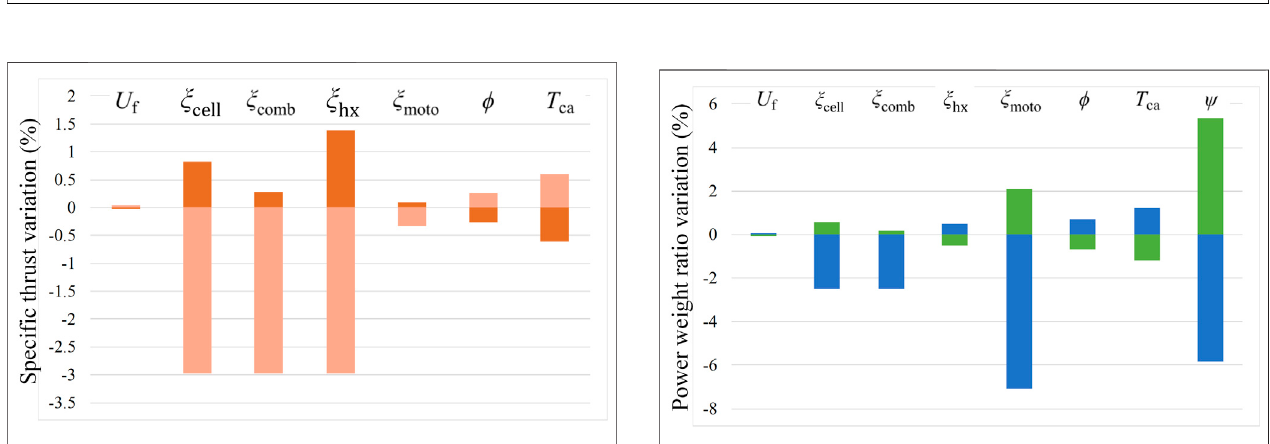
Frontiers in Energy Research |